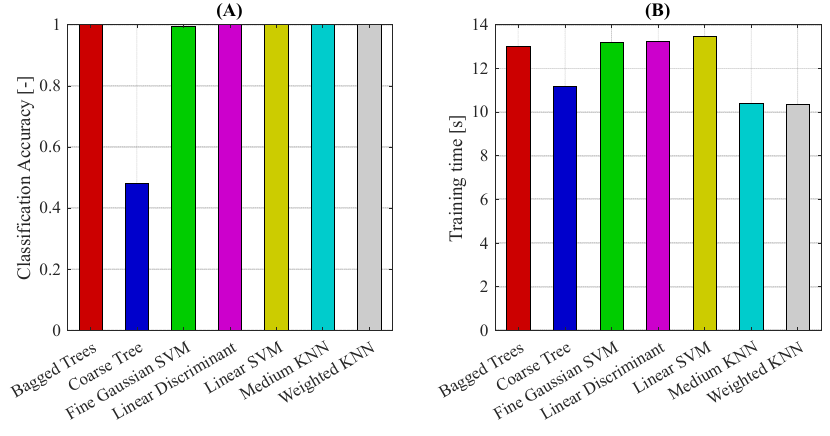
Figure 10. Classifier accuracy ( A ) and training time ( B ) with 13,000 features (raw signal, sensor 1).